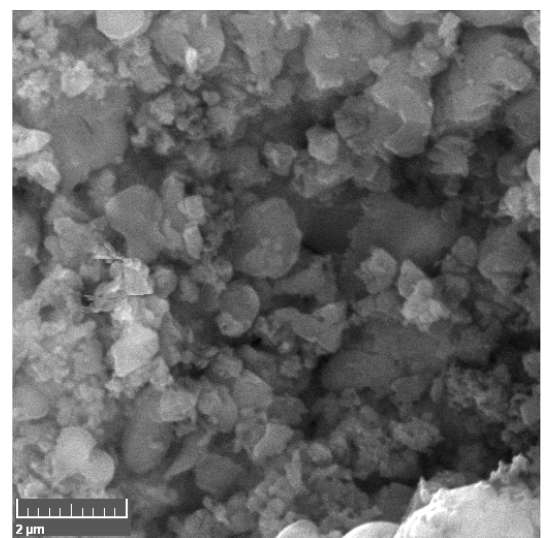
Figure 5. SEM micrograph of AzoMCM.